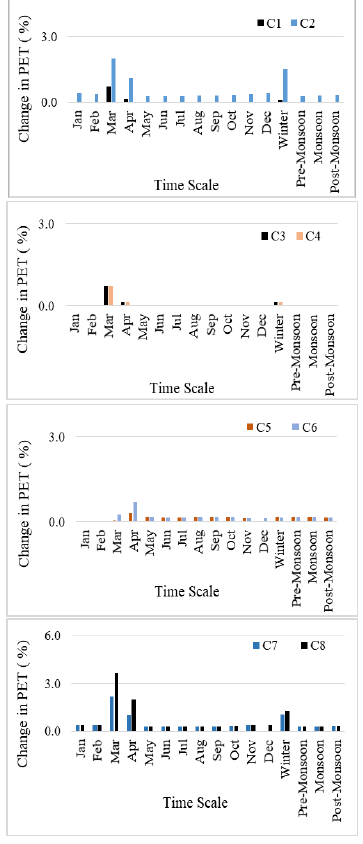
Figure 5. Percentage change in PET in the basin during different future climate change